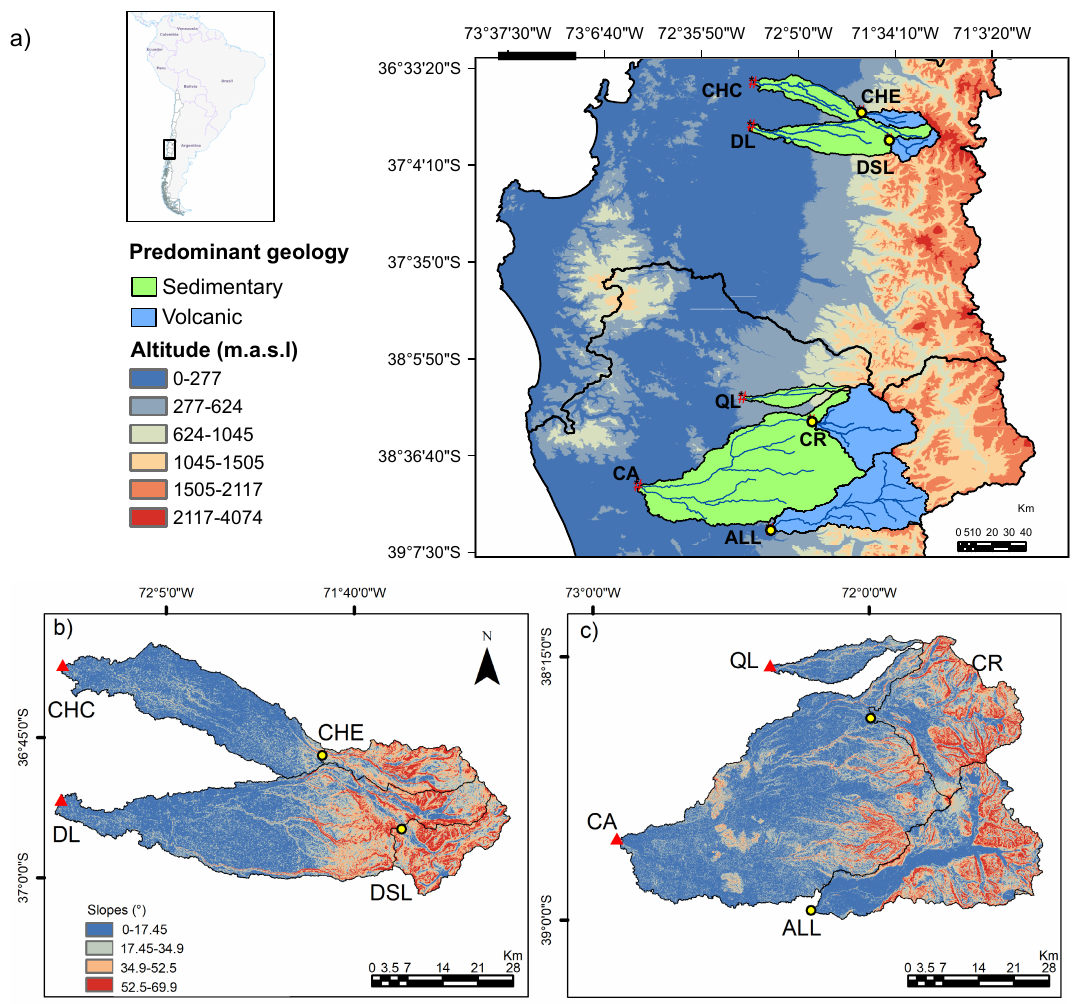
Figure 1. Study area and elevation map ( a ). Yellow circles correspond to volcanic watersheds and red triangles to sedimentary watersheds. Additionally, a slope map of watersheds ( b and c ) is shown.